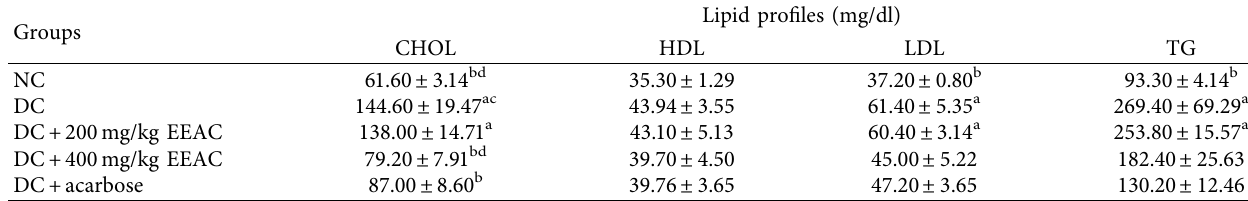
Table 4: Lipid profiles of experimental animals after 28 days oral administration of EEAC from antidiabetic activity study. Groups